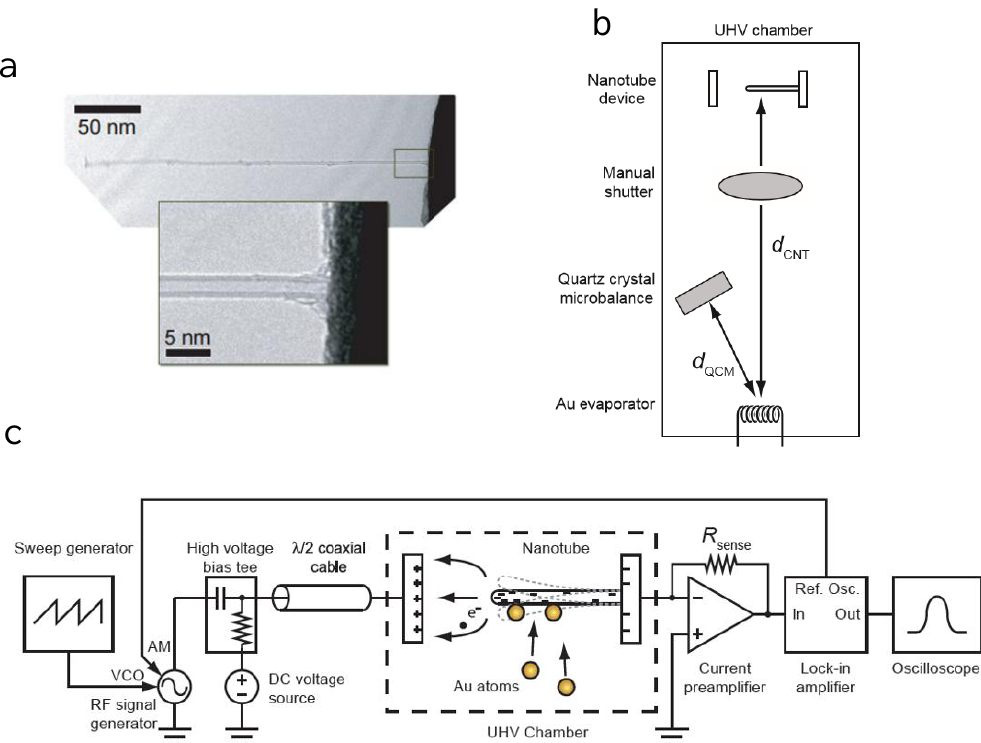
Figure 3. Nanomechanical mass spectrometer device and schematics. ( a ) TEM image of a nanomechanical mass spectrometer device constructed from a double-walled CNT (DWCNT), ( b ) The nanotube device was placed at one end of an ultra-high vacuum (UHV) chamber, ( c ) Schematic of the nanomechanical resonance detection circuit. Adapted with permission from [28], Copyright Nature Publishing Group, 2008.